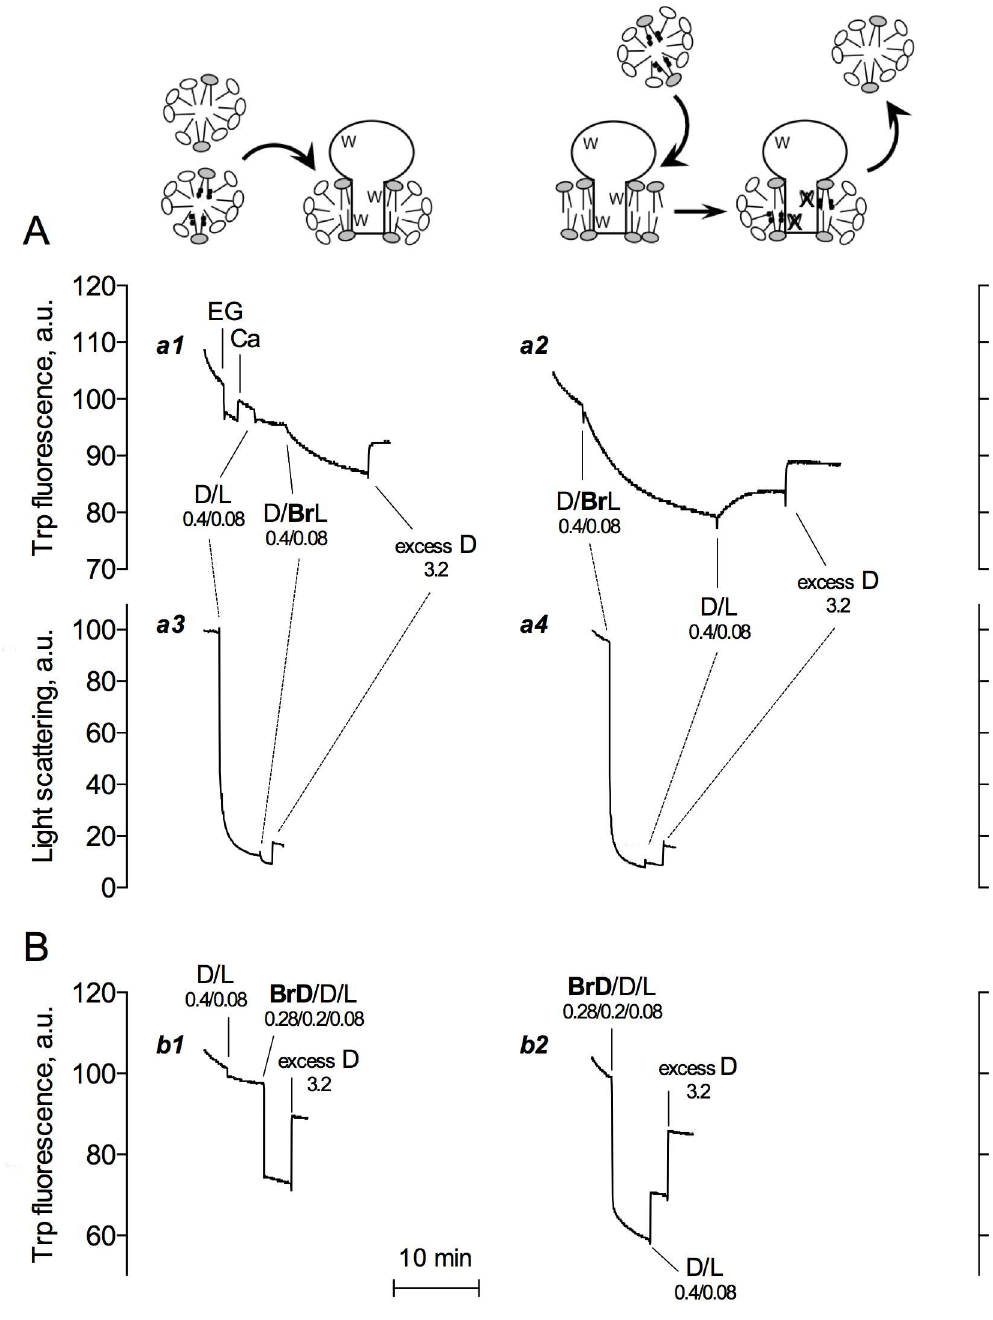
Fig 1. Kinetics of brominated PC exchangebetween mixed DDM/lipid micelles and SERCA1asolubilized at the samedetergent/lipid ratio. (A) Trace a1 , to 2 mL of SR vesiclessuspended at 0.04 mg protein/mL(together with 0.02 mg endogenous lipid/mL)in buffer A at 20˚C, 0.6 mM EGTA (EG) followedby 0.6 mM CaCl 2 (Ca) were first addedas controls, to illustratethe classical Ca 2+ -dependent changesin SERCA1a intrinsicfluorescence as well as the usualdown-driftin fluorescence intensity accompanying such measurements (see Materialsand Methods). SERCA1a was then solubilizedby addingmixed DDM/egg PC micelles(D/L, containingthe unbrominated lipidat a ratio of 5 g detergent/g lipid, i.e. ~7 mol/mol) at final concentrations of 0.4 and0.08 mg/mL for DDM and eggPC, respectively. Mixedmicelleswith brominated lipids(D/BrL) were then addedand this was followedby additionof excess DDM (to reach a final total DDM concentrationof 4 mg/mL). For Trace a2 ,additionswere performedfirst with brominated (D/BrL) and then with unbrominated (D/L) lipid. Traces a3 and a4 correspondto experimentssimilarto